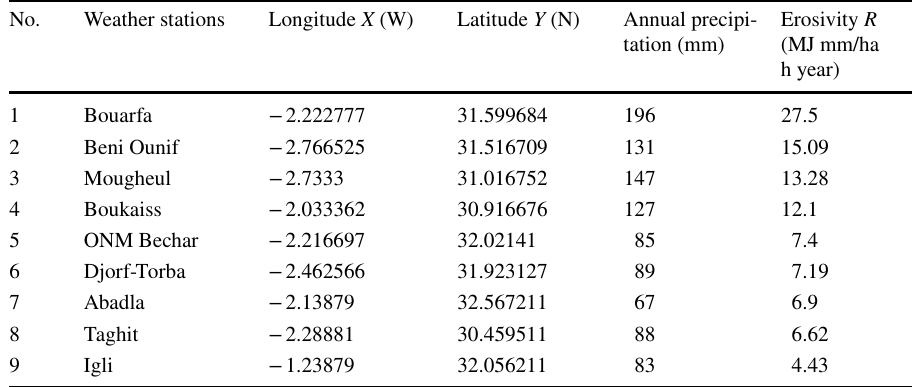
Table 1 Erosivity values and location of meteorological stations used